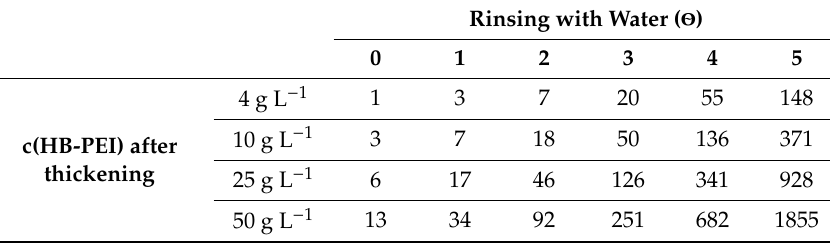
Figure 7. Rinsing of filtration circuit with water. Table 6. Enhancement of Cu(II) selectivity toward unbound species by increased polymer concentration (thickening) and rinsing of filtration circuit (with water); 4 g L − 1 HB-PEI in the initial concentrate Table 5. Reduction of unbound species in the filtration circuit by rinsing with water (calculated by was considered. Equation (2)).